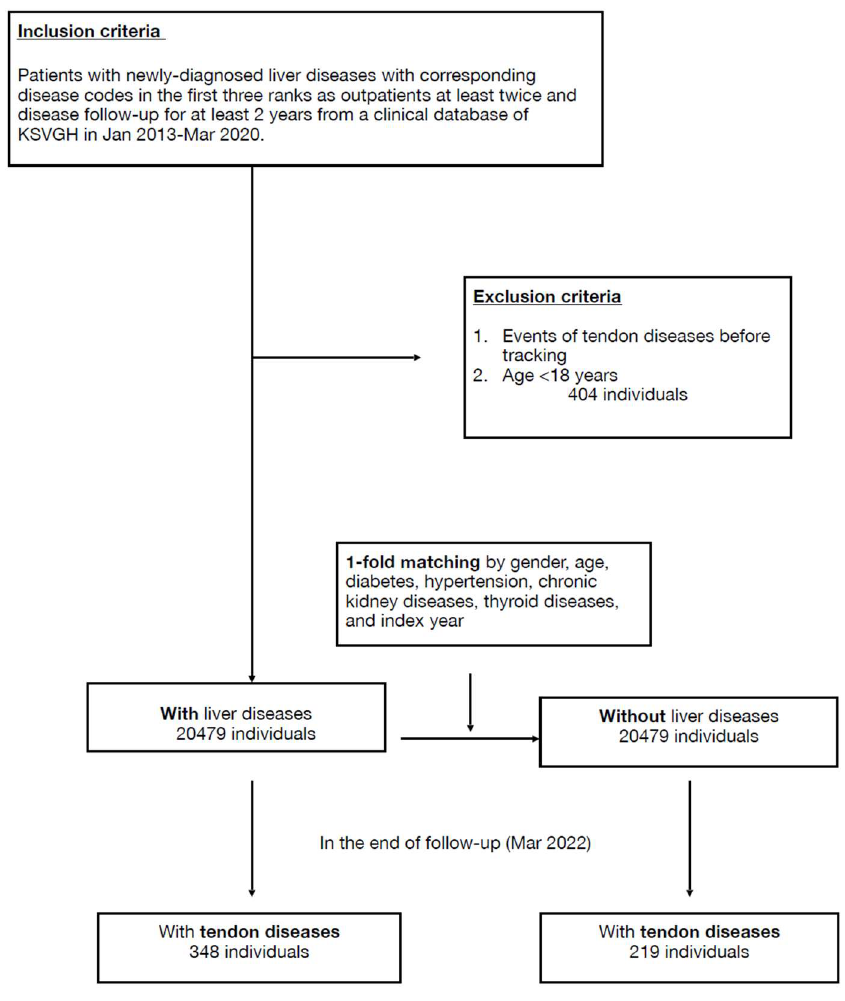
Figure 1. Flowchart. Figure 1.